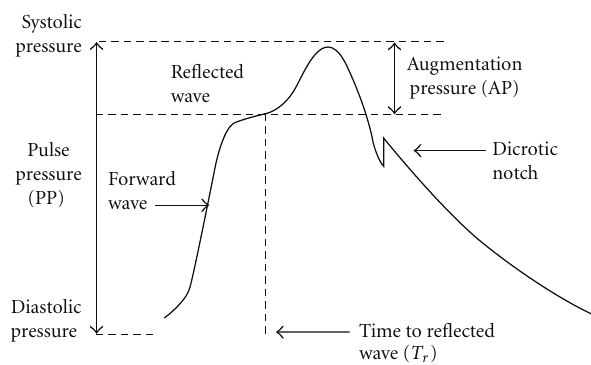
Figure 1: Aortic pulse pressure waveform. Systolic and diastolic pressures are the peak and trough of the waveform. Augmentation pressure is the additional pressure added to the forward wave by the reflected wave. Augmentation index is defined as the augmentation pressure as a percentage of pulse pressure. The dicrotic notch represents closure of the aortic valve and is used to calculate ejection duration. Time to reflection is calculated as the time at the onset of the ejected pulse waveform to the onset of the reflected wave.